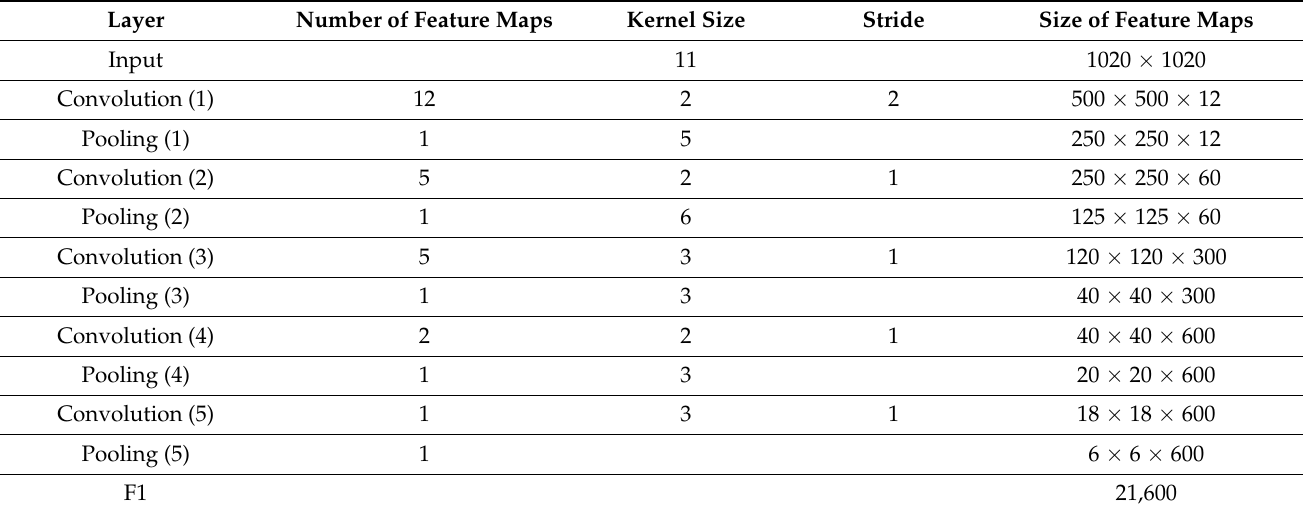
Table 1. Describe the structure of the convolutional neural network (CNN) models model.